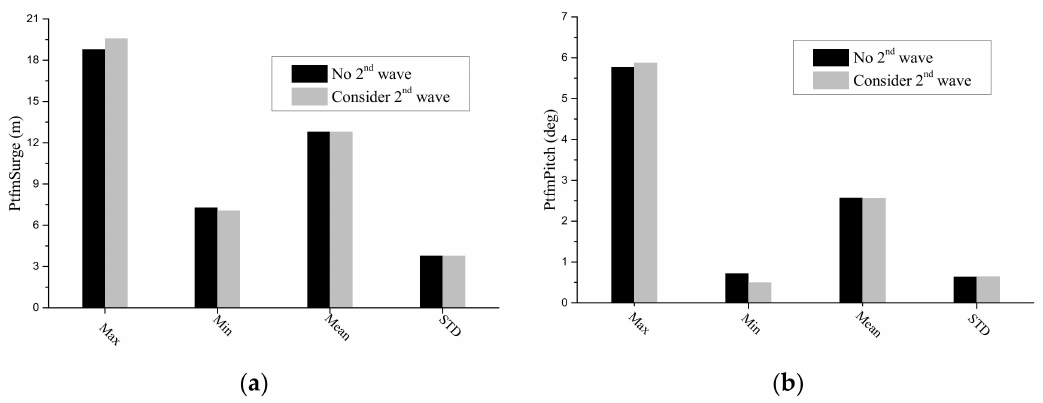
Figure 10. The statistics values of platform responses with or without considered 2nd order wave load: ( a ) Platform surge motion; ( b ) platform pitch